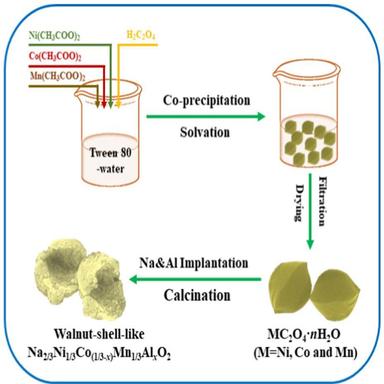
XRD patterns of walnut-shell-like NaNCMA-0, NaNCMA-3, NaNCMA-6 samples and NaNCM micro particles.